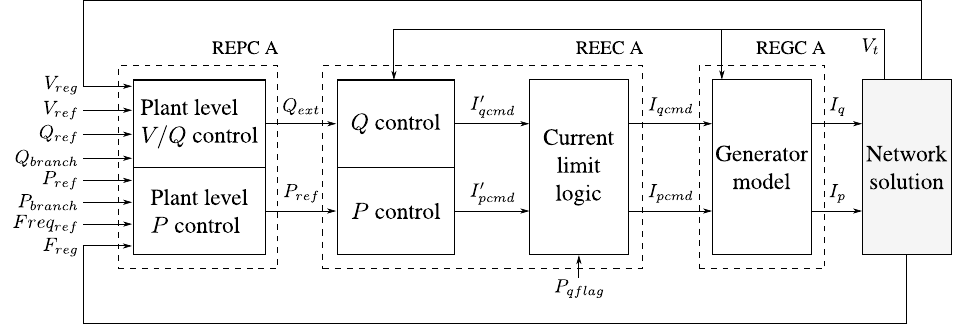
Figure 4. Second-generation solar PV plant models.